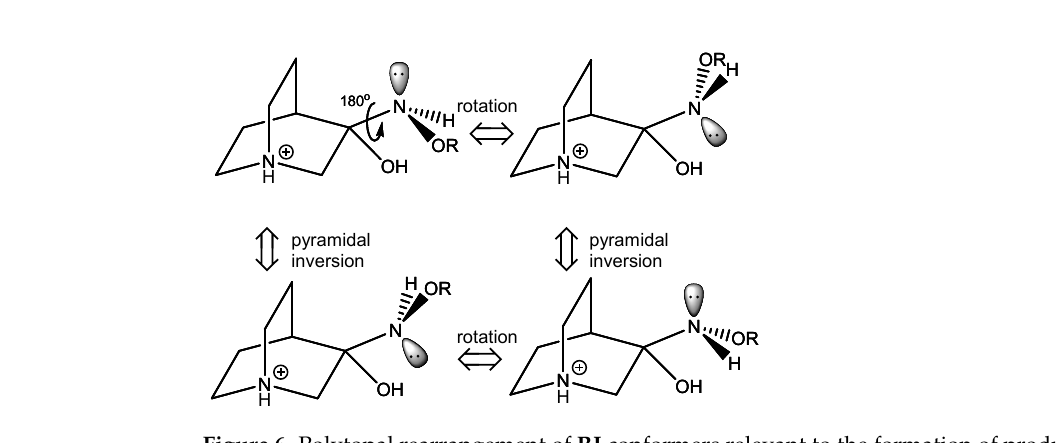
Table 4. Calculated differences of standard Gibbs energies of formation ΔΔ f Gº relative to the ( E )- isomers for hydrochlorides 1 – 4 (B3LYP-D3/6-311++G(d,p)). Compound